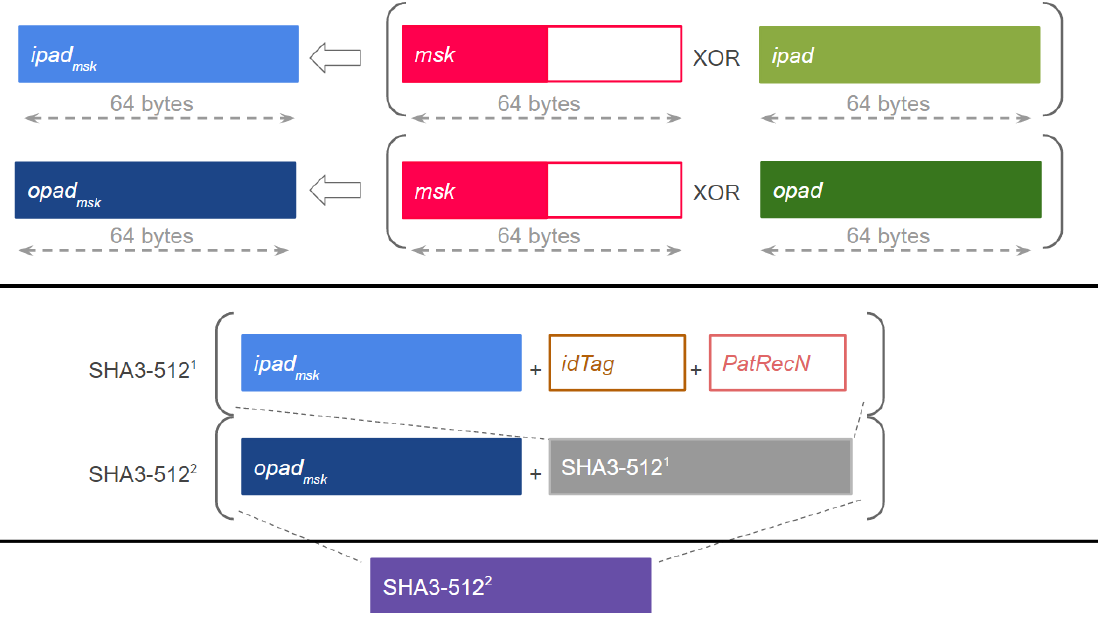
Figure 1. Keyed-hash message authentication code